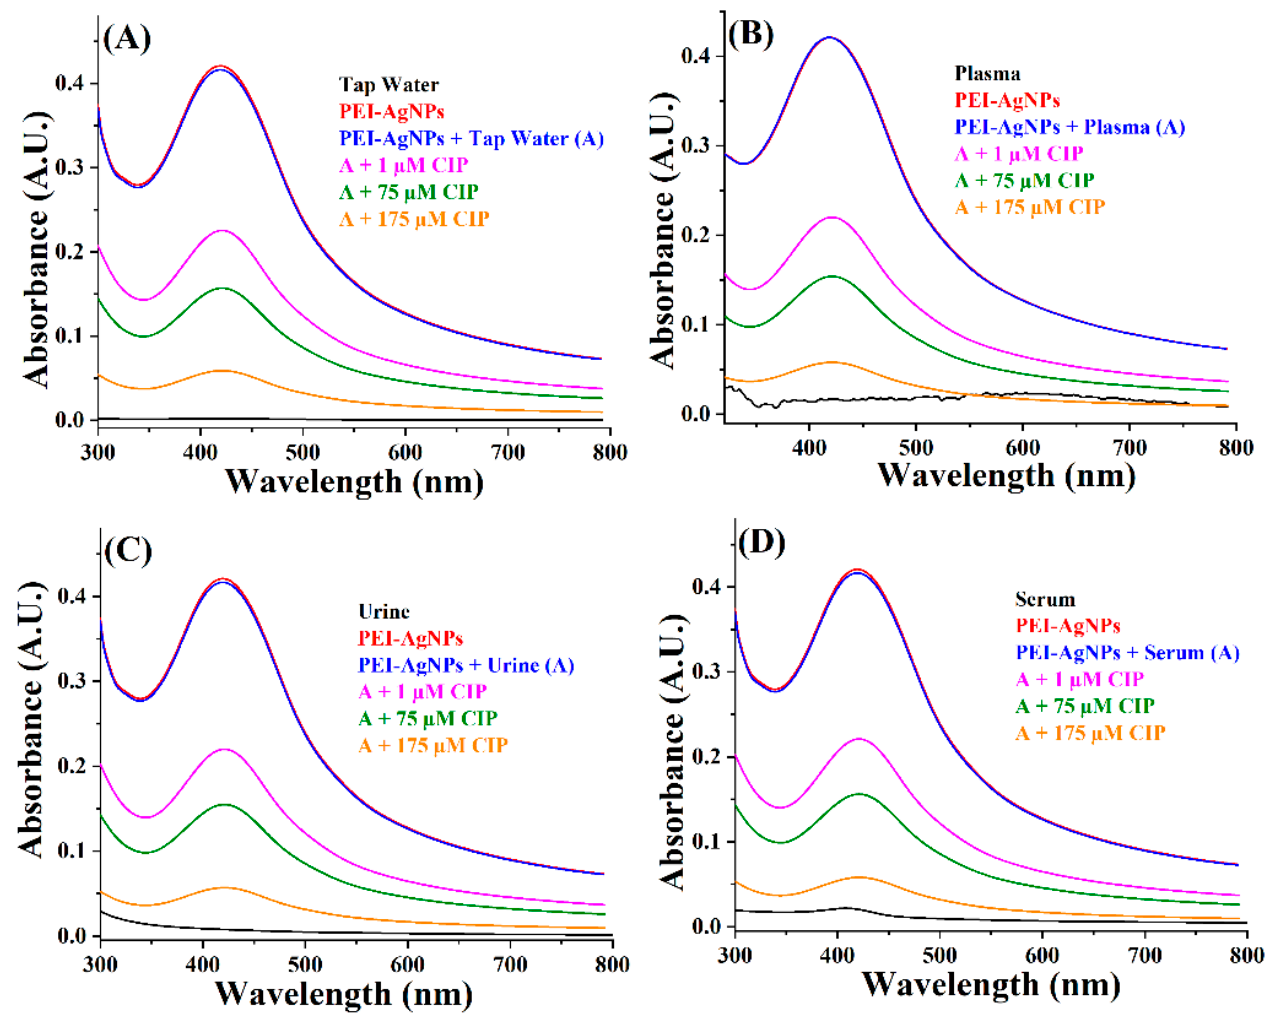
Figure 7. SPR band of PEI-AgNPs after the addition of different concentrations of CIP in ( A ) tap water, ( B ) plasma, ( C ) urine, ( D ) blood serum; plasma, urine, and serum samples were diluted with deionized water in a ratio of 1:5 before making the mentioned concentration of CIP.